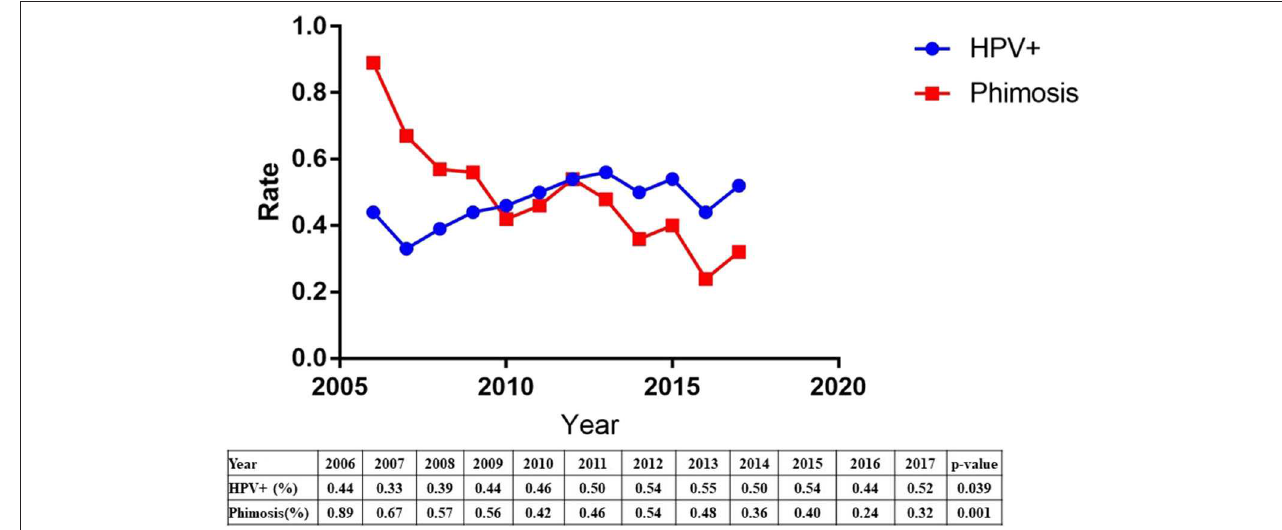
FIGURE 2 | The trend of increasing HPV prevalence and decreasing phimosis from 2006 to